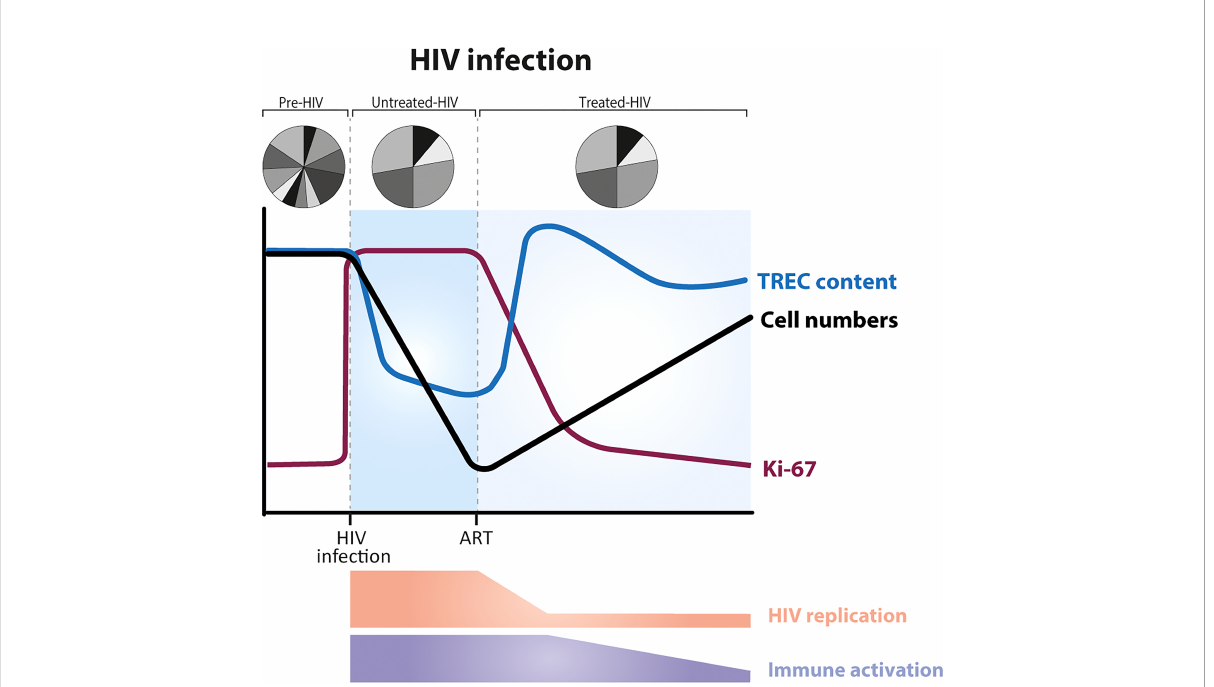
FIGURE 3 Dynamics of T cells during HIV infection, before and after the start of ART (anti-retroviral treatment). HIV infection is characterized by a severe and gradual depletion of CD4 + T cells (black line), which rise again after the start of ART (73). The fraction of Ki-67 positive CD4 + T cells (purple line) is increased during untreated HIV infection. ART leads to a rapid reduction of T-cell proliferation rates, long before T-cell numbers have recovered (61, 74). In most HIV-infected individuals, the average TREC content of CD4 + T cells is signi fi cantly decreased during untreated infection (due to increased T-cell proliferation) and increases on commencement of ART (75, 76) (blue line). TCR repertoire diversity is reduced, with a small proportion of TCRs highly expanded (77). Levels of immune activation and viral replication are high during untreated HIV infection, and decrease during